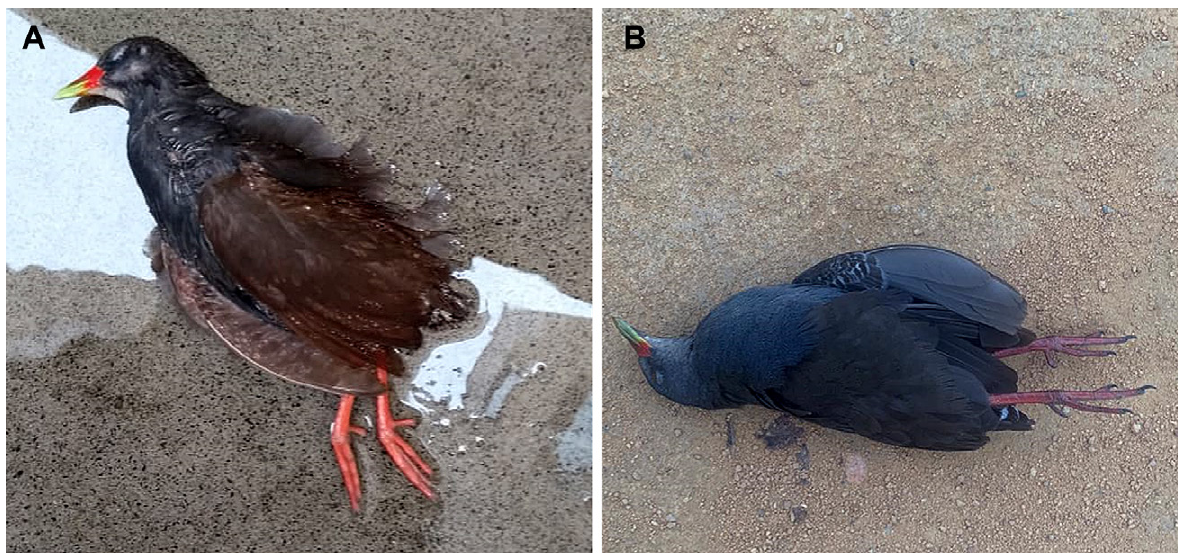
Figure 2. Adult of Neocrex erythrops. A. From Santa Teresa (MBML 7718). B. From Rio Bananal, Espírito Santo state,